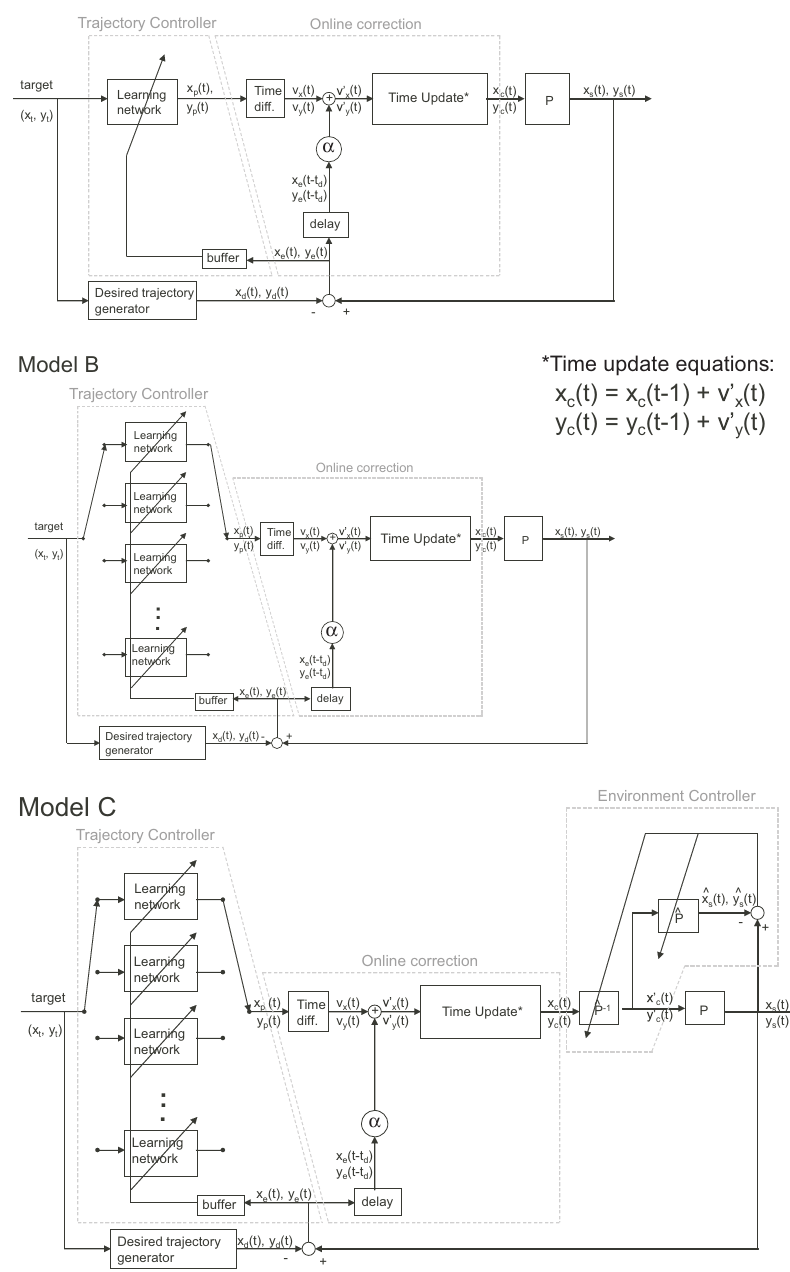
Figure 2. Block diagram of the three simulated models. P (Plant) is the matrix that represents the rotation of the visual feedback. P -1 is the internal inverse model of the plant. The desired trajectory generator uses a bell-shaped velocity profile to generate the desired trajectory. The “Time diff” block calculates the velocity sequence that would have produced the planned trajectory using the planned position sequence. Using the planned velocity sequence as the input command, the online correction takes the delayed error as a proportional correction term to give the new velocity to guide where the cursor should go relative to the current location. The learning networks in the models are basis function (BF) networks where each basis function is an increasing order monomial of time. A . Detailed simulation model for model A (simple learning model). B . Detailed structure for model B (motor program). C . Detailed structure for model C (two-system learning